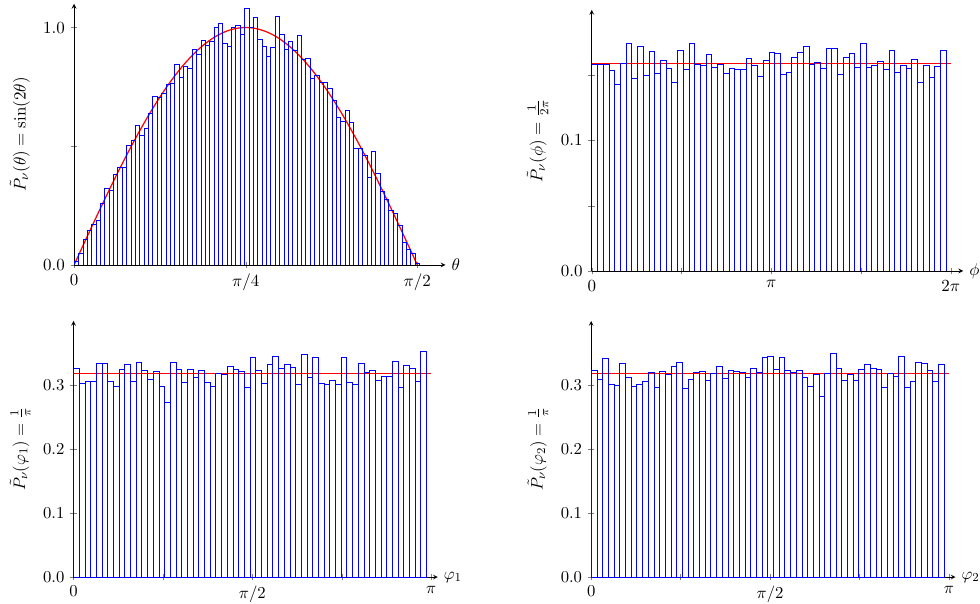
Figure 2 . Probability density functions for the mixing angle and phases of the complex seesaw ensembles with N = 2. The red curve corresponds to the analytic result while the histogram corre- sponds to numerical results (with 2 : 5 10 4 dimensionless light neutrino mass matrices generated). (cid:2) The top and bottom rows show the pdfs for the mixing angle (cid:18) , the CP-violating phase (cid:14) , and the unphysical phases ’ 1 and ’ 2 (note the range is halved due to the extra freedom ’ i ’ i (cid:25) [11]). ! (cid:6) ( (cid:12) = 2) seesaw ensemble is the (cid:12)rst moment (the average singular values). Therefore,